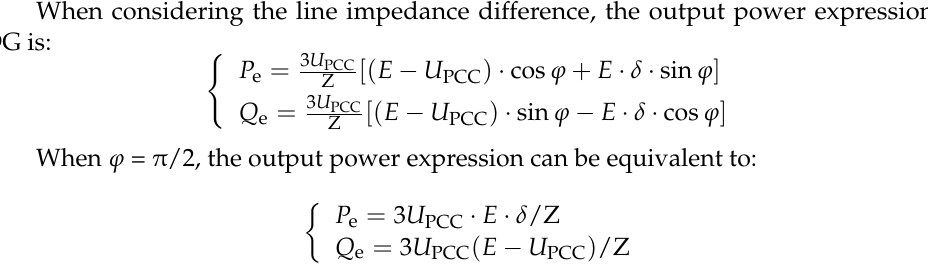
Figure 4. Schematic diagram of DG output power .